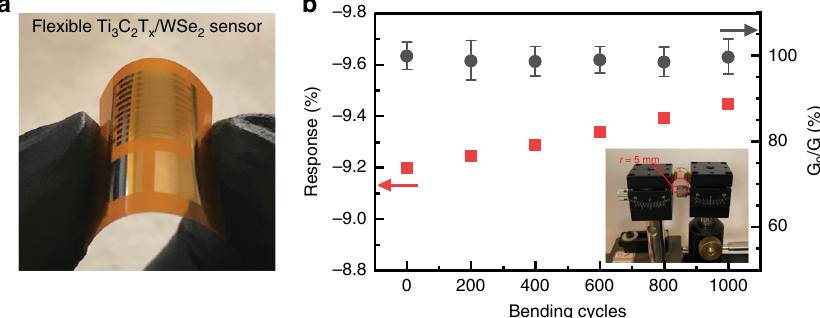
Fig. 6 Mechanical stability of hybrid Ti 3 C 2 T x /WSe 2 fi lms. a Photograph of a fl exible Ti 3 C 2 T x /WSe 2 nanohybrid sensor. b Changes in ethanol